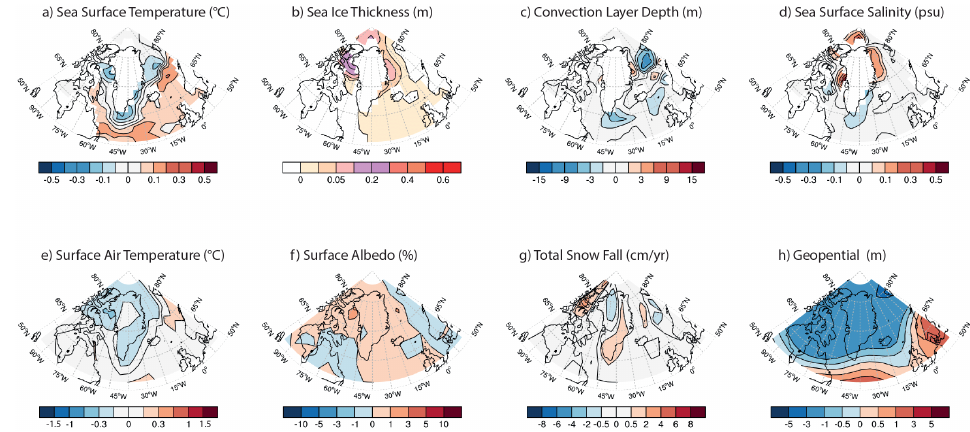
Figure 9. CALV–FWFf differences of 1000-year averages: (a) sea surface temperature, SST ( ◦ C, non-linear colour scheme); (b) sea-ice thickness (m, non-linear colour scheme); (c) convection layer depth (CLD) (m); (d) sea surface salinity, SSS (psu); (e) air temperature, TAIR ( ◦ C); (f) surface albedo, ALB (%, non-linear colour scheme); (g) total snowfall, SNOW (cmyr − 1 , non-linear colour scheme); (h) geopotential (m, non-linear colour